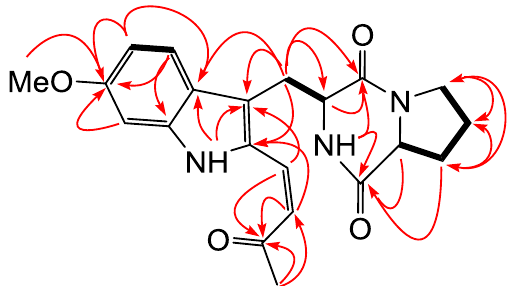
Fig. 2 Key 1 H– 1 H COSY (black bold line) and HMBC (red arrow line from H to C) correlations of compound